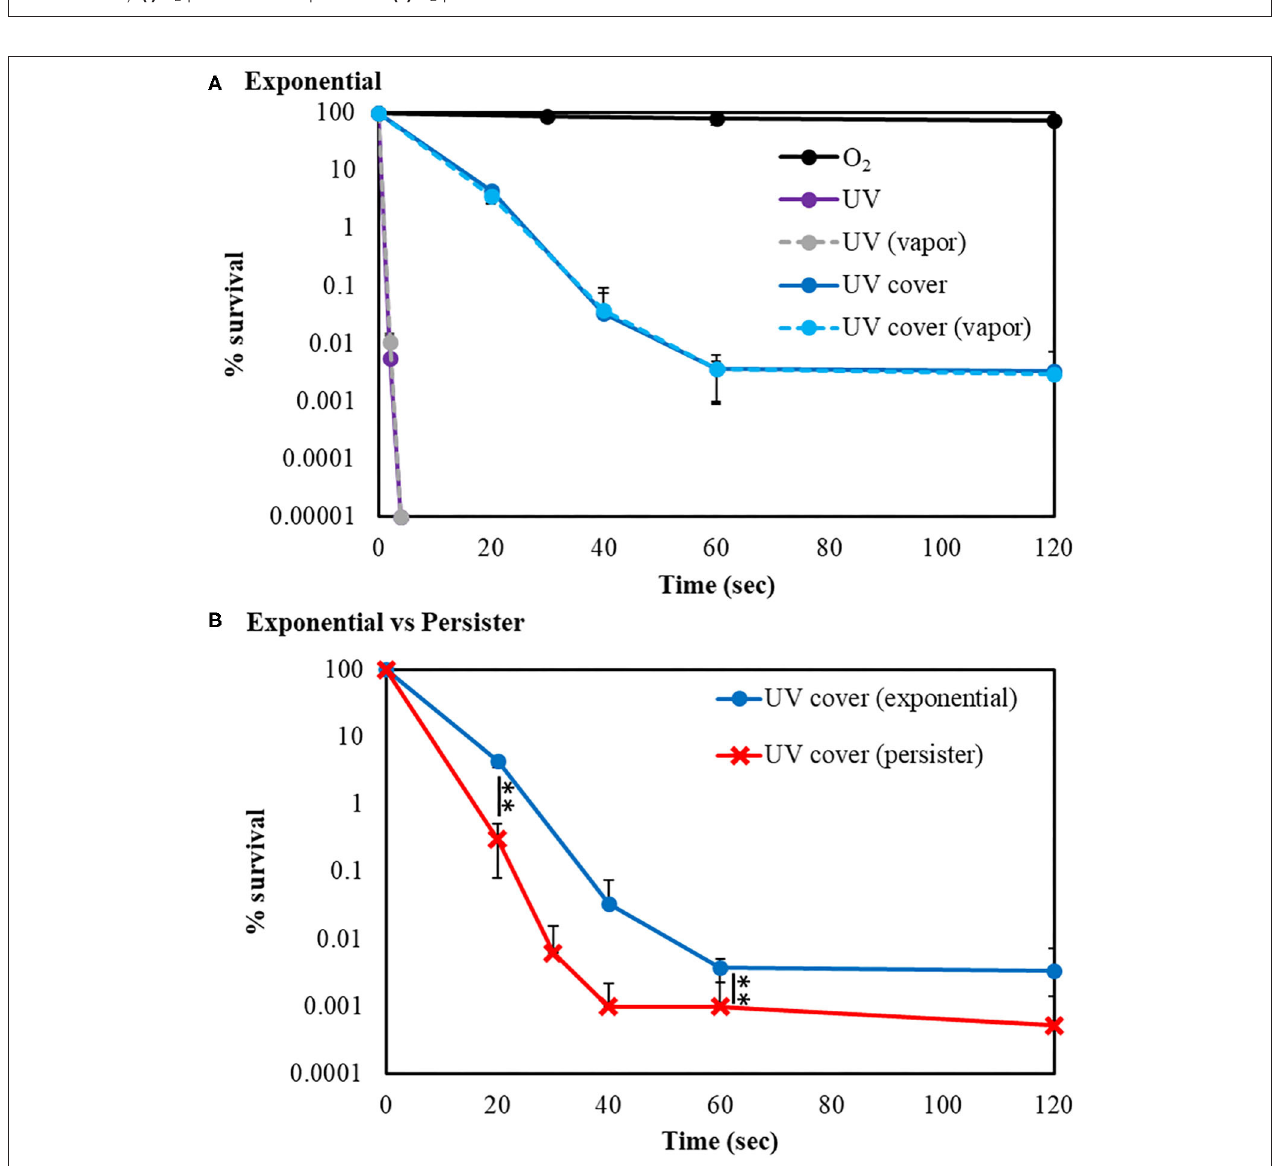
FIGURE 2 | UV sterilization of E. coli exponential cells and persister cells with or without cover. (A) Survival rate of E. coli BW25113 exponential cells after sterilization in UV (purple) or UV cover (blue) modes. Vapor conditions using a vaporizer are indicated as broken lines (gray is UV, and light blue is UV cover). Black plots are O 2 treatment as a control. (B) Comparison of E. coli BW25113 exponential cells (blue) and persister cells (red) in UV cover mode treatment. Each exponential or persister cell sample was plated on M9 agar and treated in each RVR mode. Error bars indicate S.D. of at least three experiments. Student’s t -test was used to compare two groups (** P < 0.01). The values obtained in these experiments are shown in Supplemental Table 2 .